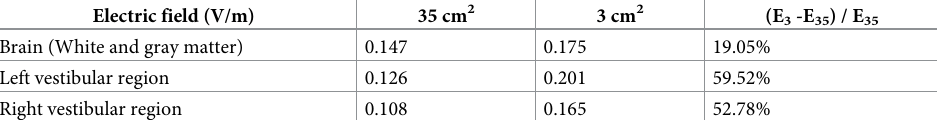
Table 1. Maximum induced E-field (based on 99th percentile) in the brain and vestibular regions across the two models. The percentage increase of E-field with respect to the larger electrode model is noted in the final